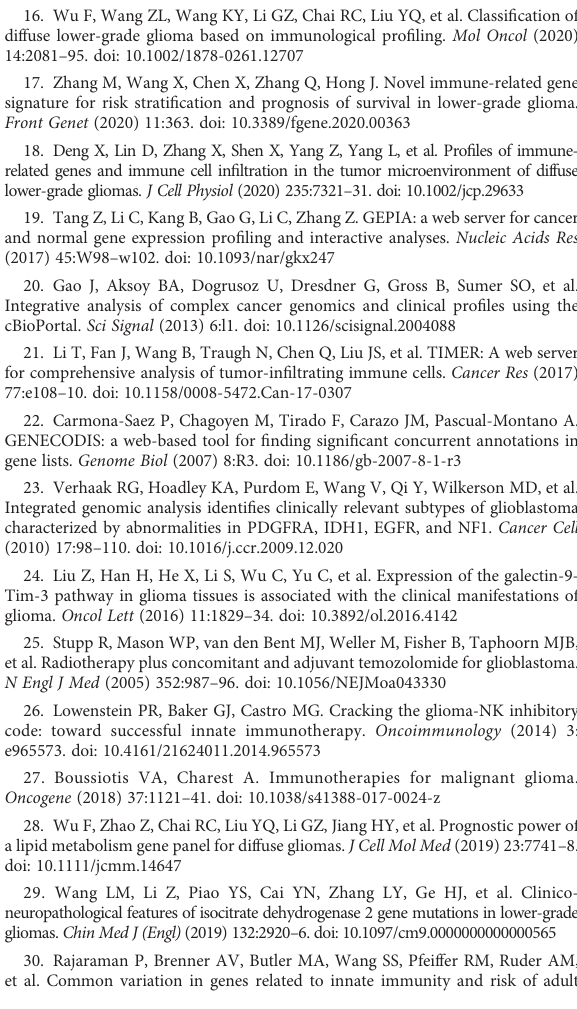
SUPPLEMENTARY FIGURE 1 (A)The difference of ITGB2 methylation in IDH wt and mutation gliomas.(B)The difference of ITGB2 mRNA expression in MGMT- methylated and unmethylated gliomas. SUPPLEMENTARY FIGURE 2 Kaplan-Meier curves of low and high ITGB2 DNA promoter CpG sites in LGG patients. cg01344119 (A) , cg19221500 (B) , cg02117924 (C) , cg18012089 (D) , cg17039369 (E) , cg13315706 (F) , cg20556503 (G) , cg21303803 (H) , cg07274406 (I)